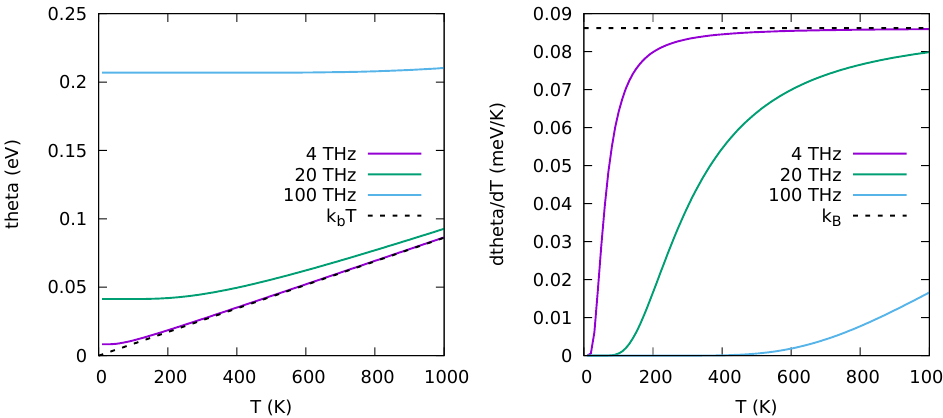
Figure 2. θ ( ω , T ) (left panel) and its temperature derivative d θ ( ω , T ) / dT (right panel) for three representative frequencies ν = ω /2 π . ν 1 = 4 THz is typical of acoustic modes in crystals; ν 2 = 20 THz is in the range of optical modes in crystals formed by light mass elements, as well as of OH and CH bending modes; ν 3 = 100 THz could correspond to C-H and O-H stretching modes. For the latter frequency, one can see that the classical behavior is never reached for T ≤ 1000